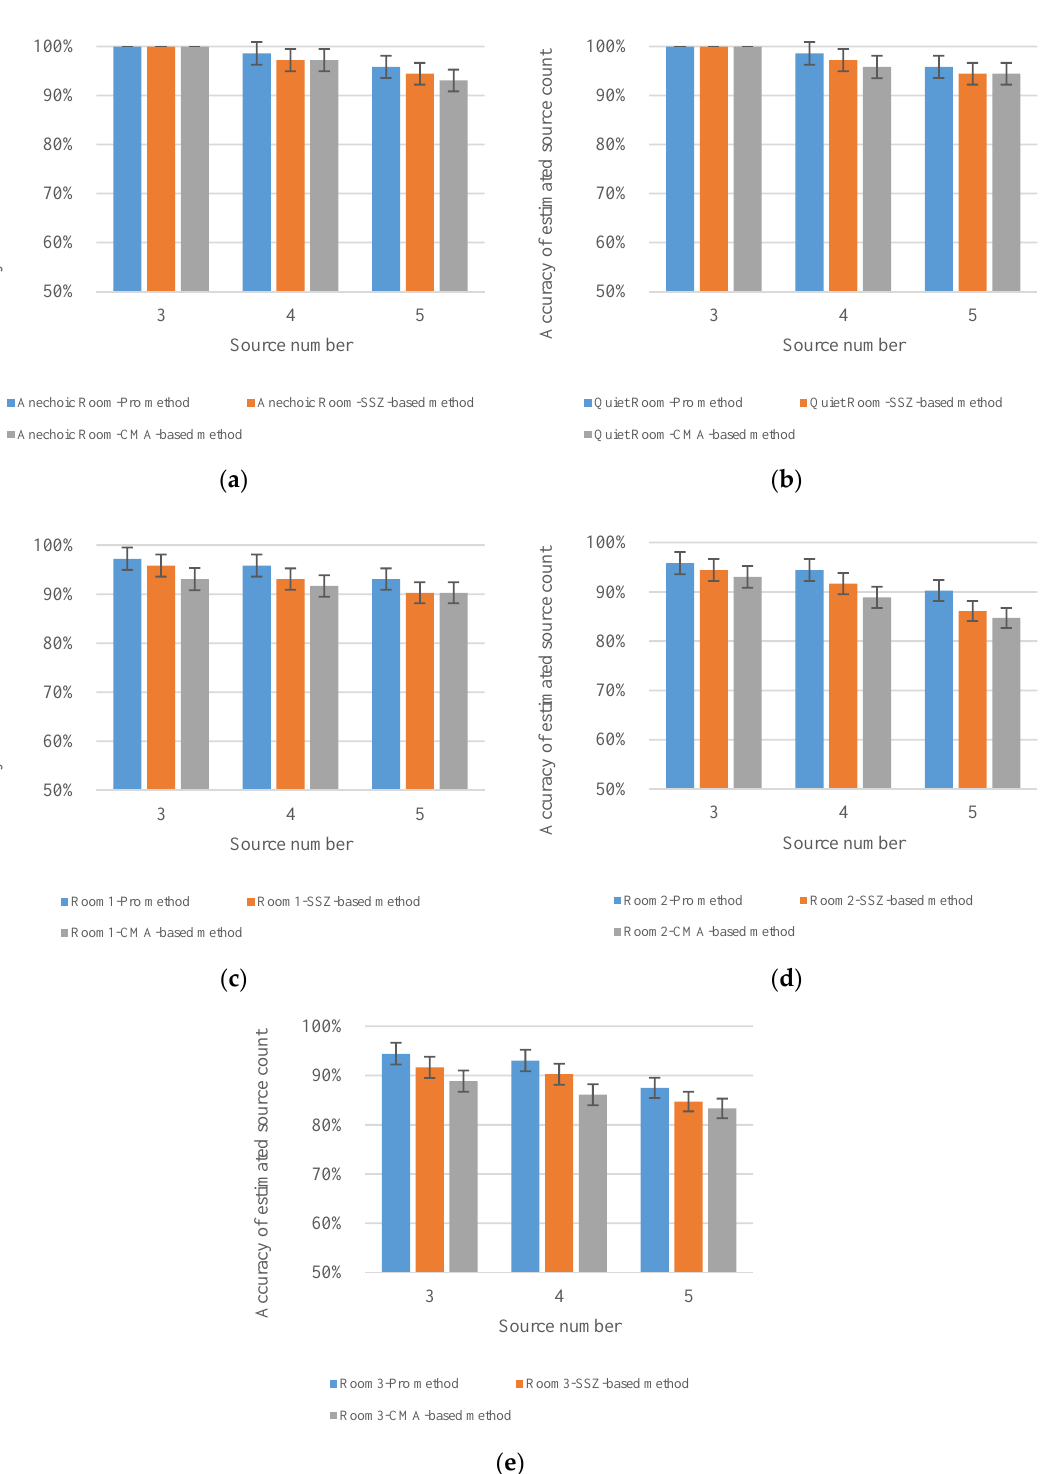
Figure 11. Objective comparison on accuracy among different sources counting algorithms under anechoic, quiet room and reverberant conditions with 95 % confidence intervals ( a ) Anechoic room; ( b ) Quiet room; ( c ) Room 1 (T60 = 250 ms); ( d ) Room 2 (T60 = 450 ms); ( e ) Room 3 (T60 = 600 ms).